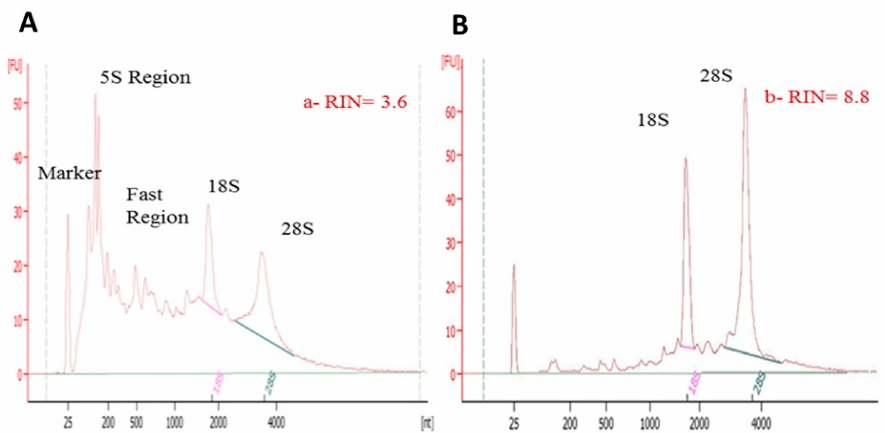
Figure 4. Electropherograms generated by an Agilent 2100 Bioanalyzer using the pico kit showing ( A ) RNA extracted using a standard protocol with an RIN = 3.6 and high peaks in the 5S and fast region, which indicates RNase degradation as compared with ( B ) RNA extracted using our optimized protocol that had low peaks in the same regions with two clear 18S and 28S regions, indicating intact RNA with RIN = 8.8.